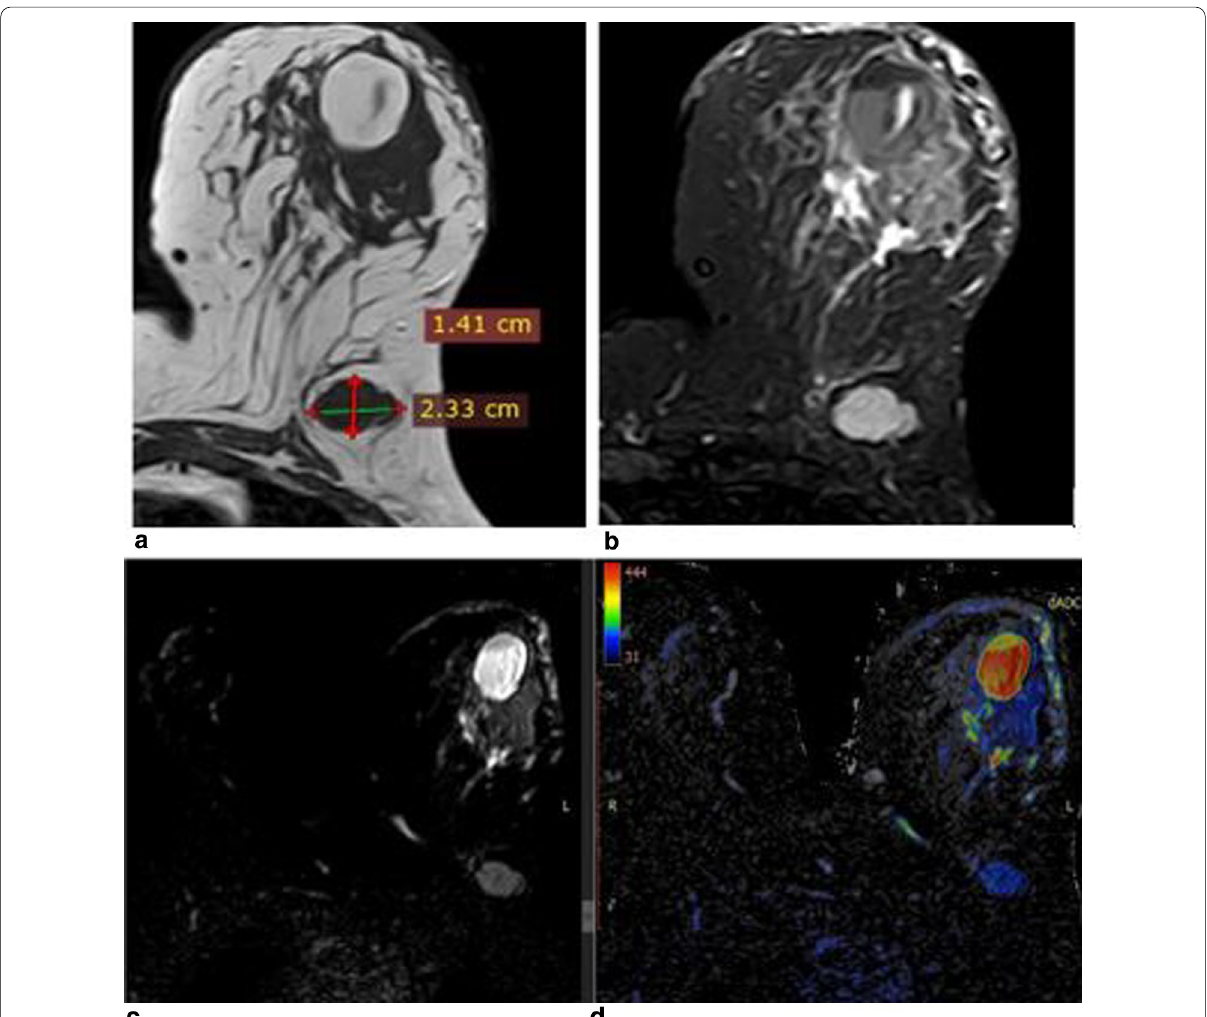
Fig. 5 A 66-year-old female a , b T1WI and STIR enlarged left axillary lymph node enlargement with lobulated outlines and lost hilum measuring (2.33 1.41 cm), c , d DW-MRI and color-coded ADC map revealed increased SI in DWI map and blue color, respectively, with ADC value × (0.497 10 − 3 mm 2 /s) matching with malignant histopathological ×